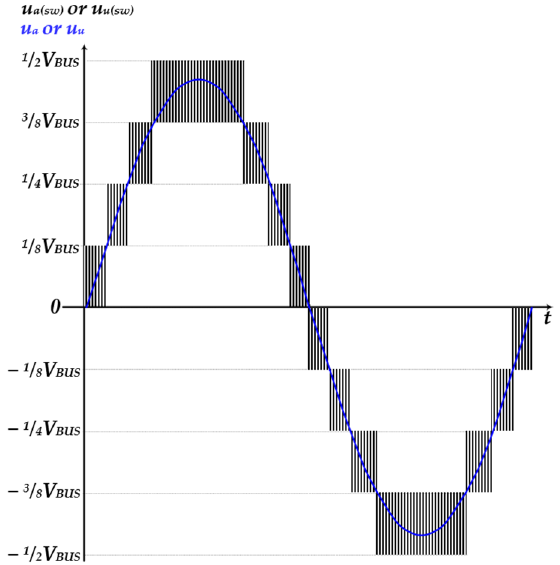
Figure 5. Line-to-line switching voltage u a(sw) (or u u(sw) ).